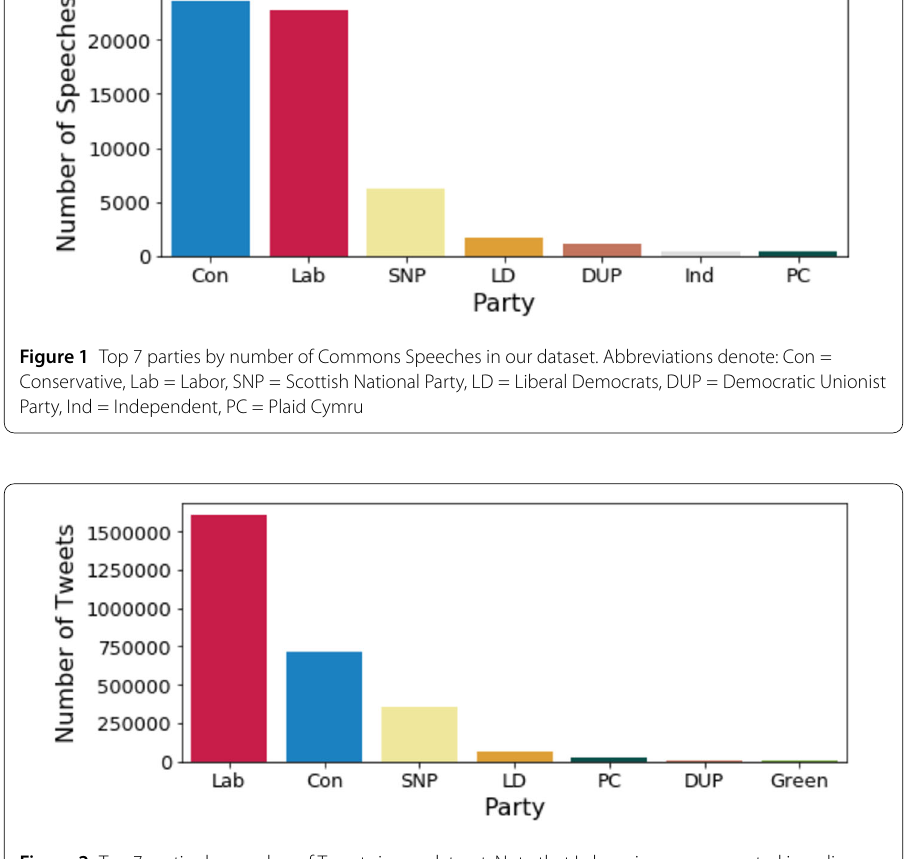
Figure 2 Top 7 parties by number of Tweets in our dataset. Note that Labour is overrepresented in online discourse, and Conservatives are underrepresented. Abbreviations denote: Con = Conservative, Lab = Labour, SNP = Scottish National Party, LD = Liberal Democrats, DUP = Democratic Unionist Party, PC = Plaid